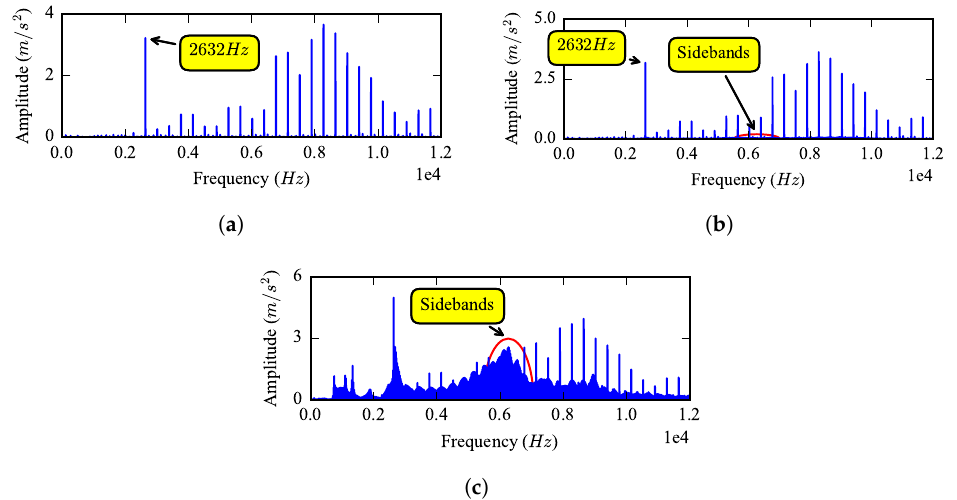
Figure 8. Spectrum of the simulated ring acceleration of the ( a ) healthy gear p = 0, ( b ) half tooth breakage fault gear p = 0.2 and ( c ) the whole tooth breakage fault p = 1.